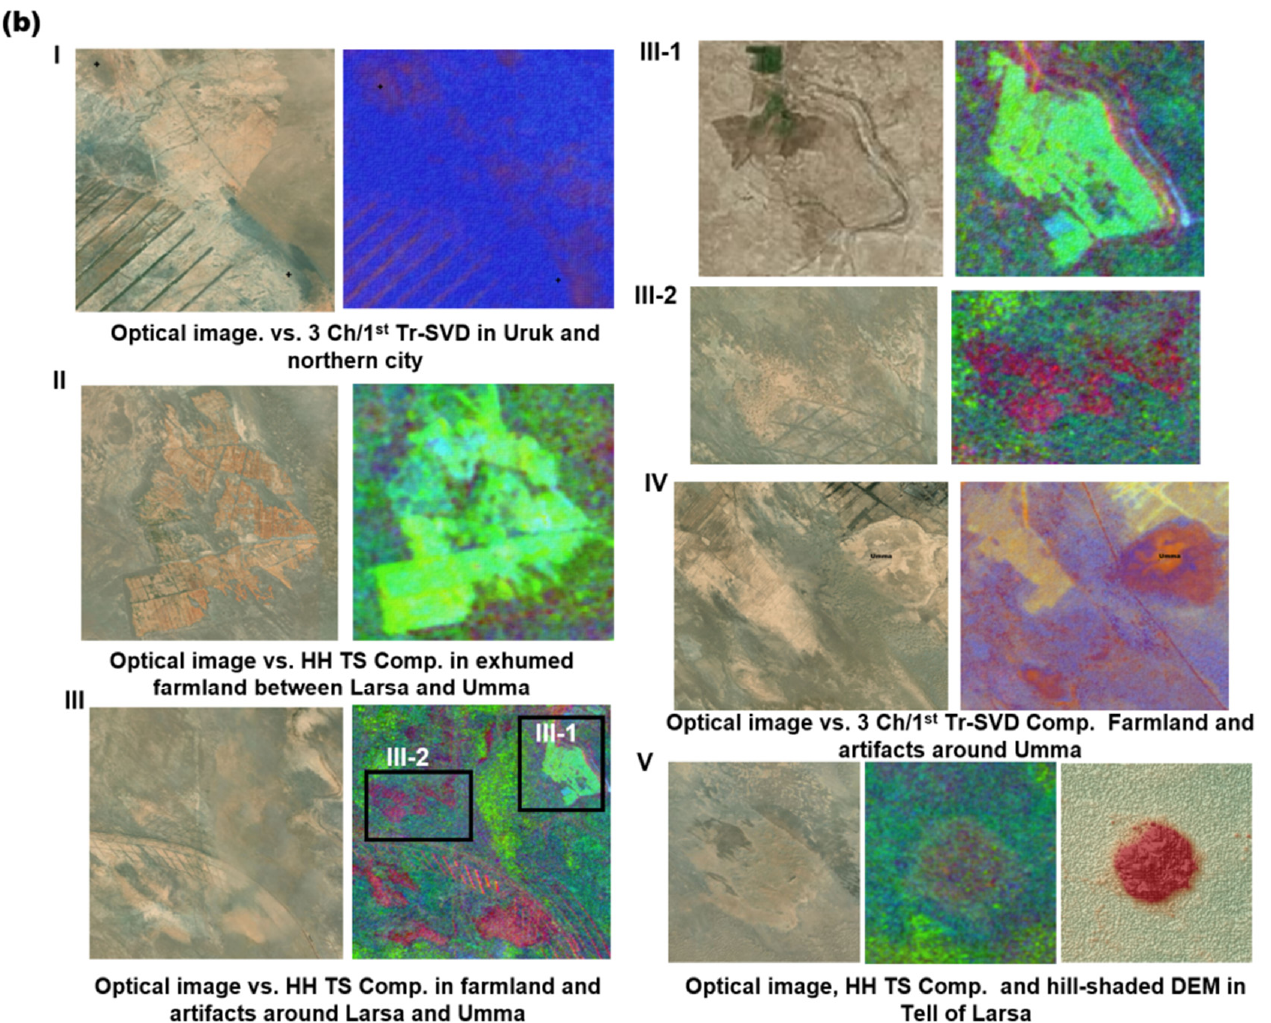
Figure 8. ( a ) InSAR Comp. in ROI-2 presenting complicated hydrological context that is covered by contemporary aeolian sediments. ( b ) The details of ROI-2 of SAR/InSAR Comps. compared to the optical image.